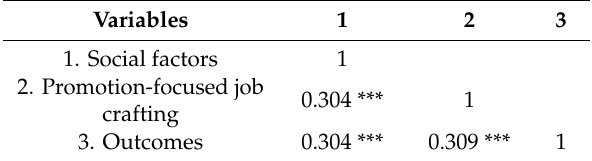
Table 4. Pooled correlation matrix based on the random-e ff ects model. Variables